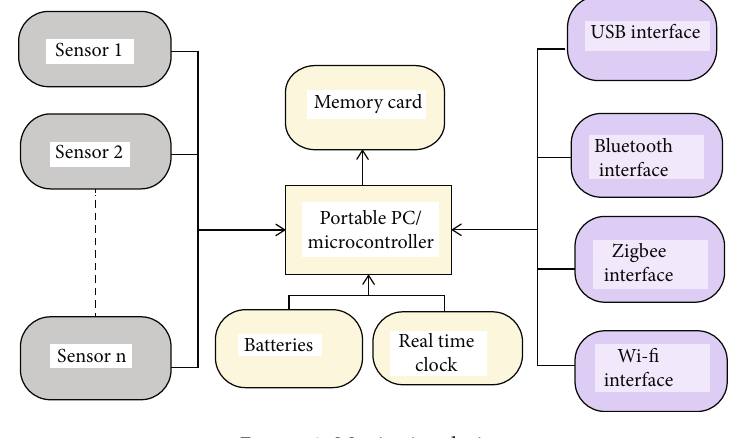
Figure 2: Monitoring